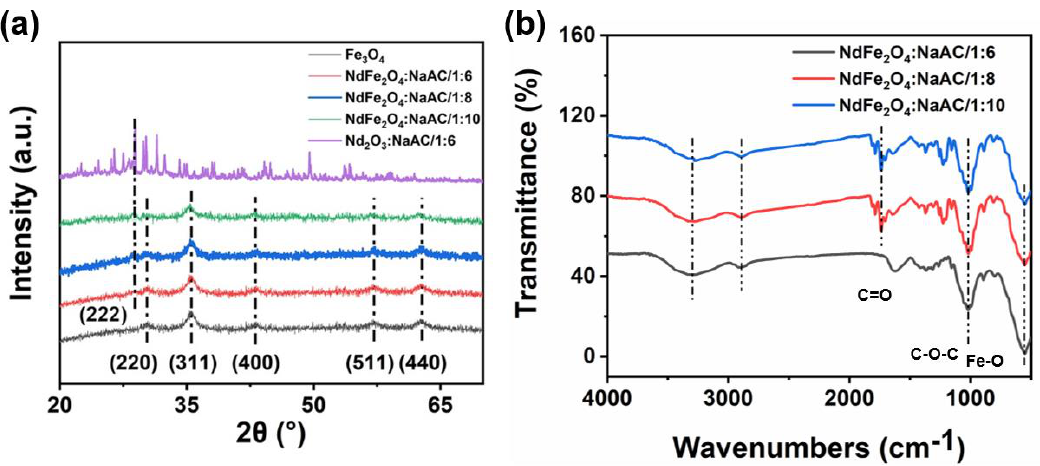
Figure 2. ( a ) XRD patterns, and ( b ) FT−IR patterns of Fe 3 O 4 and NdFe 2 O 4 NPs. The elemental composition and the corresponding chemical binding energies of each element were investigated by examining the Fe 3 O 4 and NdFe 2 O 4 NPs at different mole energies of C and O in all the curves, which were located at 286.4 and 529.8 eV, respectively, while Nd 4d was only observed in the curves of NdFe 2 O 4 . The high − resolution peak of Fe 2p and Nd 3d for Fe 3 O 4 and NdFe 2 O 4 NPs were further confirmed in Figure 3b − d. Two obvious peaks were centered at 710.1 and 724.2 eV, which corresponded to Fe 2p1 and Fe 2p3 derived from Fe − O bonds, respectively [36]. In addition, the Nd 3d narrow scan peaks were detected at 974.12, 981.6, 994.4, and 1,003.5 eV, which could be assigned to